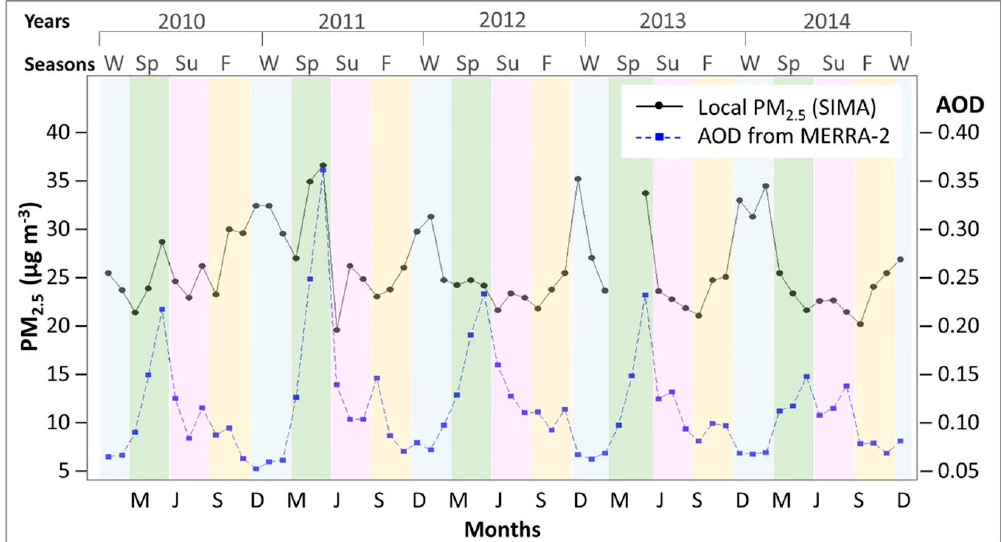
Figure 4. Comparison of temporal behavior of monthly AOD means obtained from MERRA-2 and the local monthly average PM 2.5 concentrations over the MMA (derived from SIMA data) from January